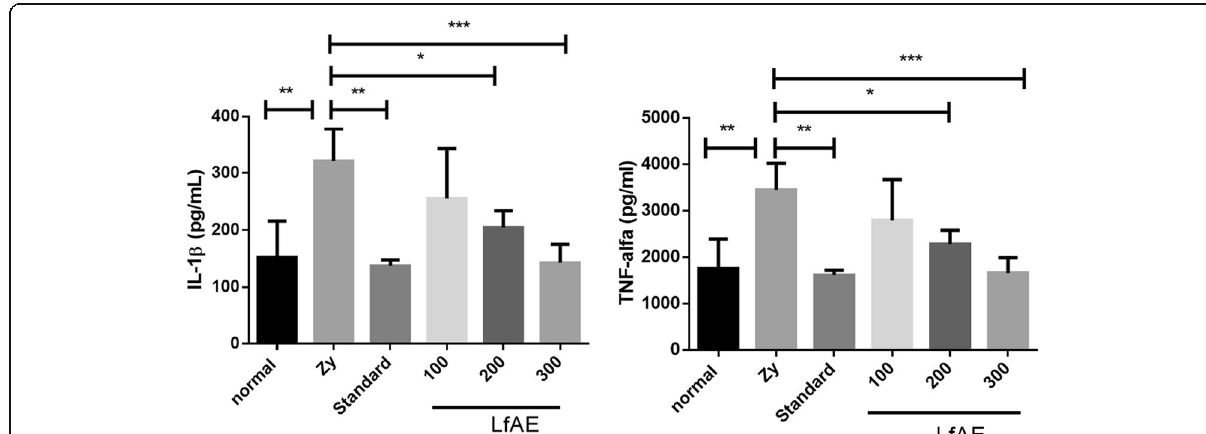
Fig. 6 Effect of LfAE (100, 200 and 300 mg/kg) and Standard on IL-1 β and TNF- α levels in the zymosan-induced arthritis model. Data are